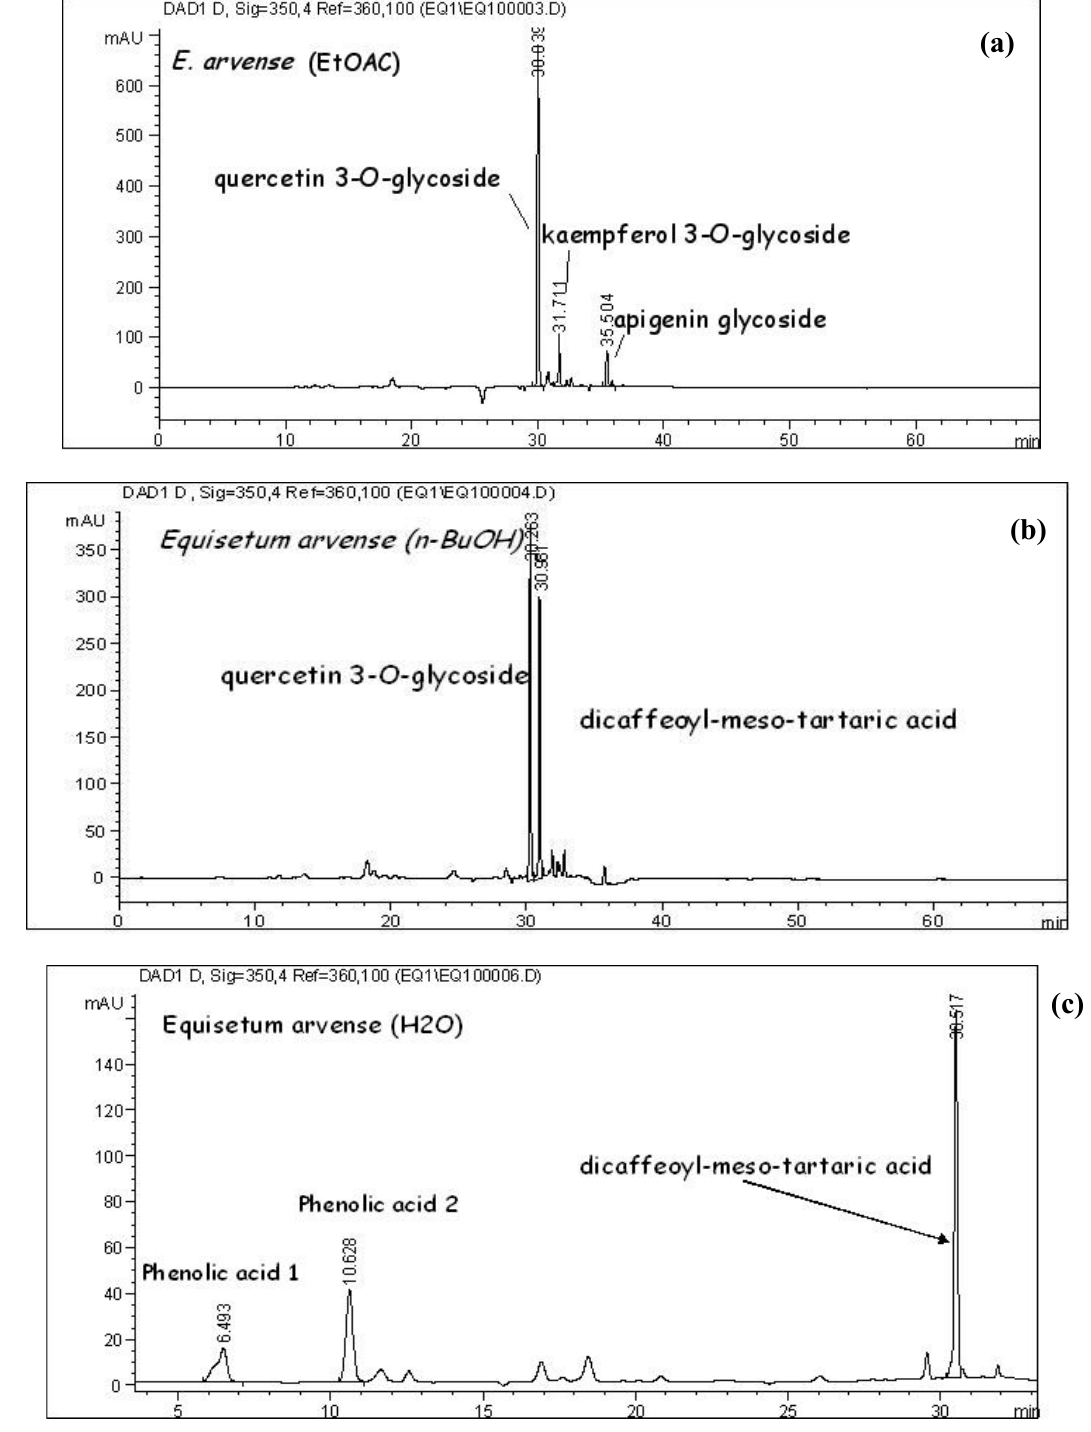
Figure 1. (a) HPLC chromatogram of EtOAc extract of E. arvense L. Detection at 350 nm. (b) HPLC chromatogram of n-BuOH extract of E. arvense L. Detection at 350